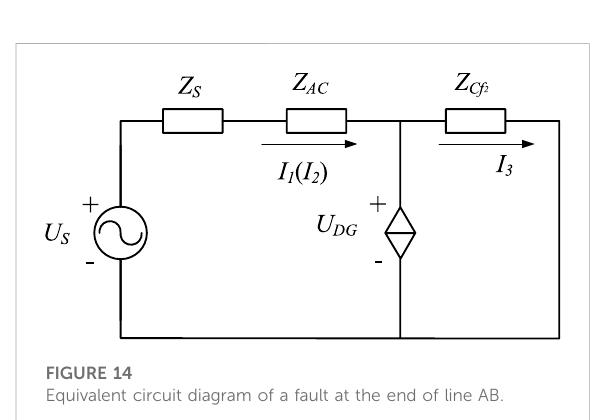
FIGURE 15 Equivalent circuit diagram of AE terminal